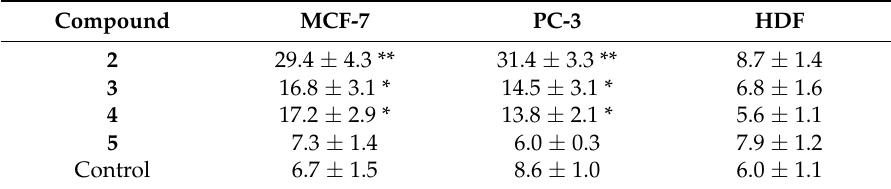
Table 2. Percentage of condensed and/or fragmented nuclei after treatment with compounds 2 – 5